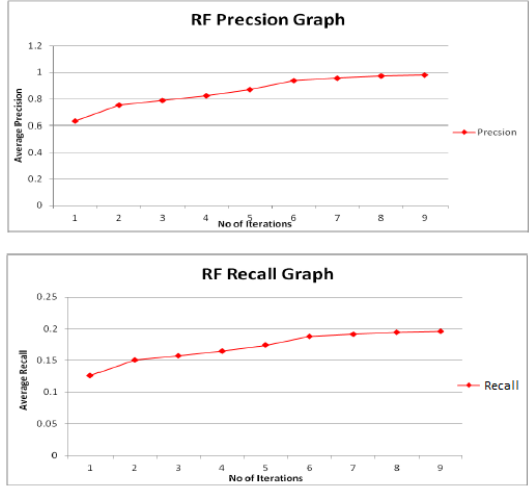
Fig. 15. Precision and Recall graphs for Relevance feedback